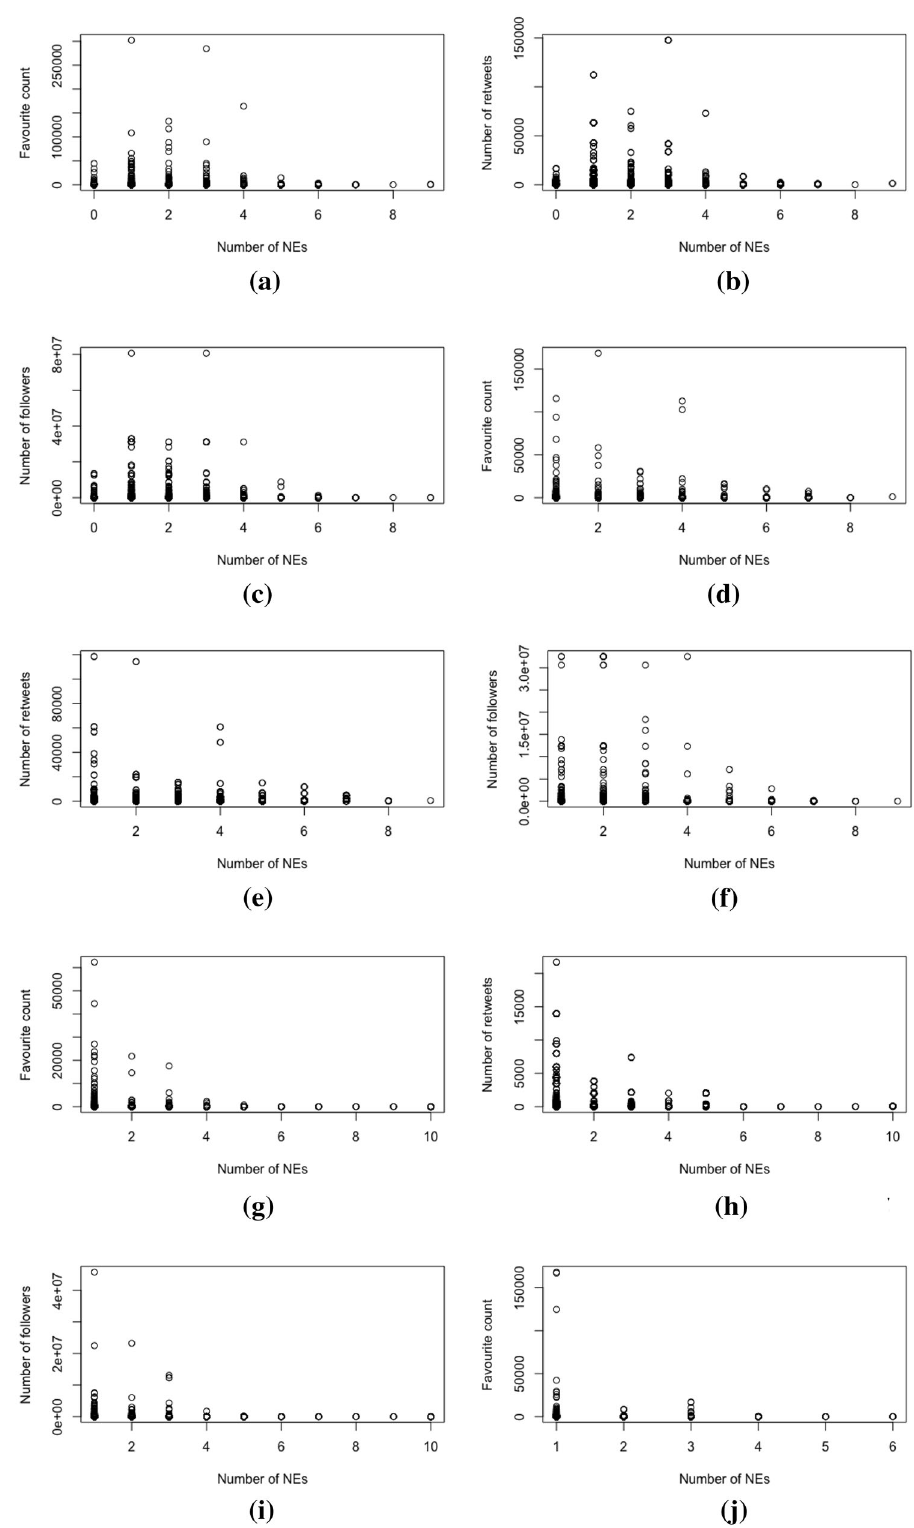
Fig. 3 Relation of parameters of interest and NEs in our datasets, a Favorite count versus NEs in Obama , b Retweets versus NEs in Obama , c Followers versus NEs in Obama , d Favorite count versus NEs in Trump , e Retweets versus NEs in Trump , f Followers versus NEs in Trump , g Favorite count versus NEs in La La Land , h Retweets versus NEs in La La Land , i Followers versus NEs in La La Land , j Favorite count versus NEs in The Voice , k Retweets versus NEs in The Voice , l Followers versus NEs in La La Land , m Favorite count versus NEs in Samsung , n Retweets versus NEs in Samsung , o Followers versus NEs in